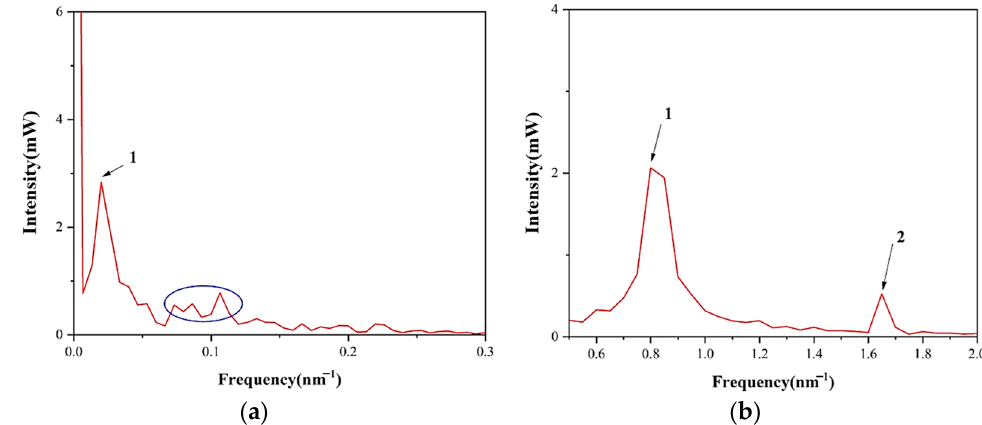
Figure 5. ( a ) Spatial frequency spectra from 0 to 0.3 nm − 1 ; ( b ) Spatial frequency spectra from 0.5 nm − 1 to 2 nm − 1 .